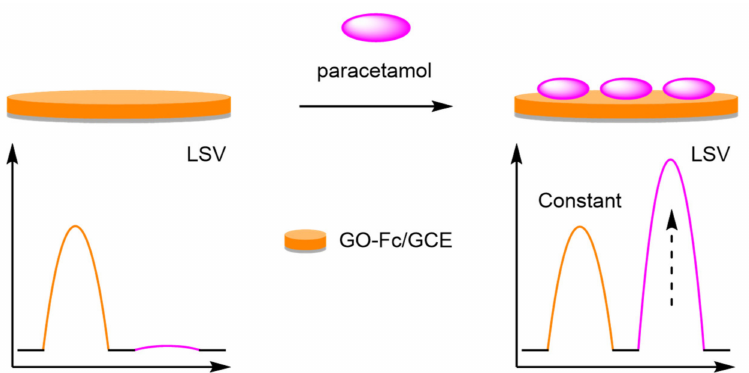
Figure 31. Schematic representation of graphene oxide-based modified electrode for the detection of